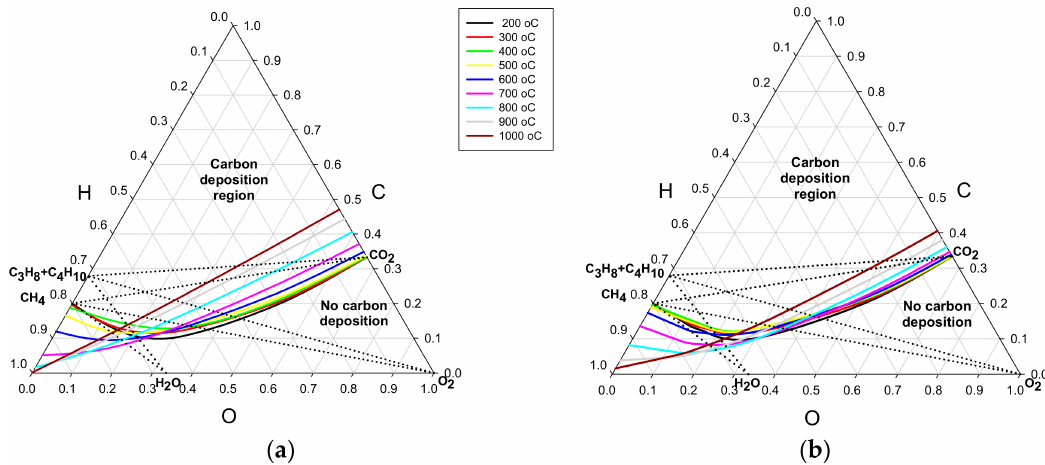
Figure 1. Ternary C–H–O diagrams for: ( a ) pressure of 3 bar; and ( b ) pressure of 30 bar.